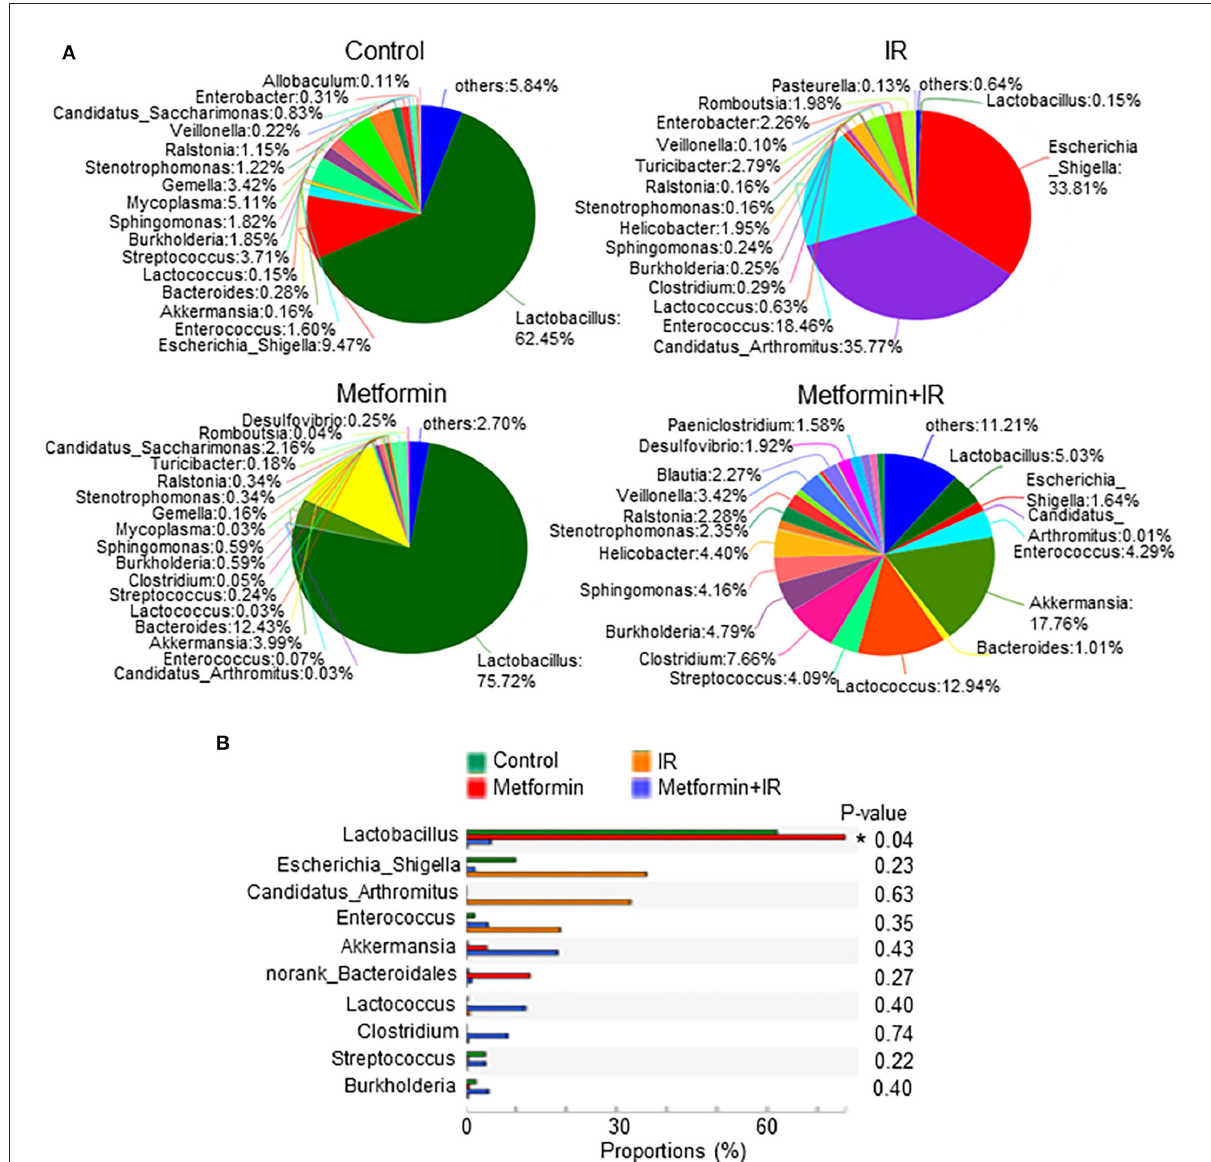
FIGURE4 Metformin increases the abundance of Lactobacillus. Female BALB/c mice were treated with abdominal IR and/or metformin as described in Figure 1. Total DNAs were isolated from intestinal contents as described in the “Materials and methods” section and subjected to 16S rRNA sequencing. (A) Pie analysis and (B) comparison of bacteria in intestinal flora in mice treated with or without metformin and identification of Lactobacillus as the most changed bacteria in abundance after metformin treatment. Data represent mean ± SEM. * P < 0.05, n = 3, metformin + IR vs.